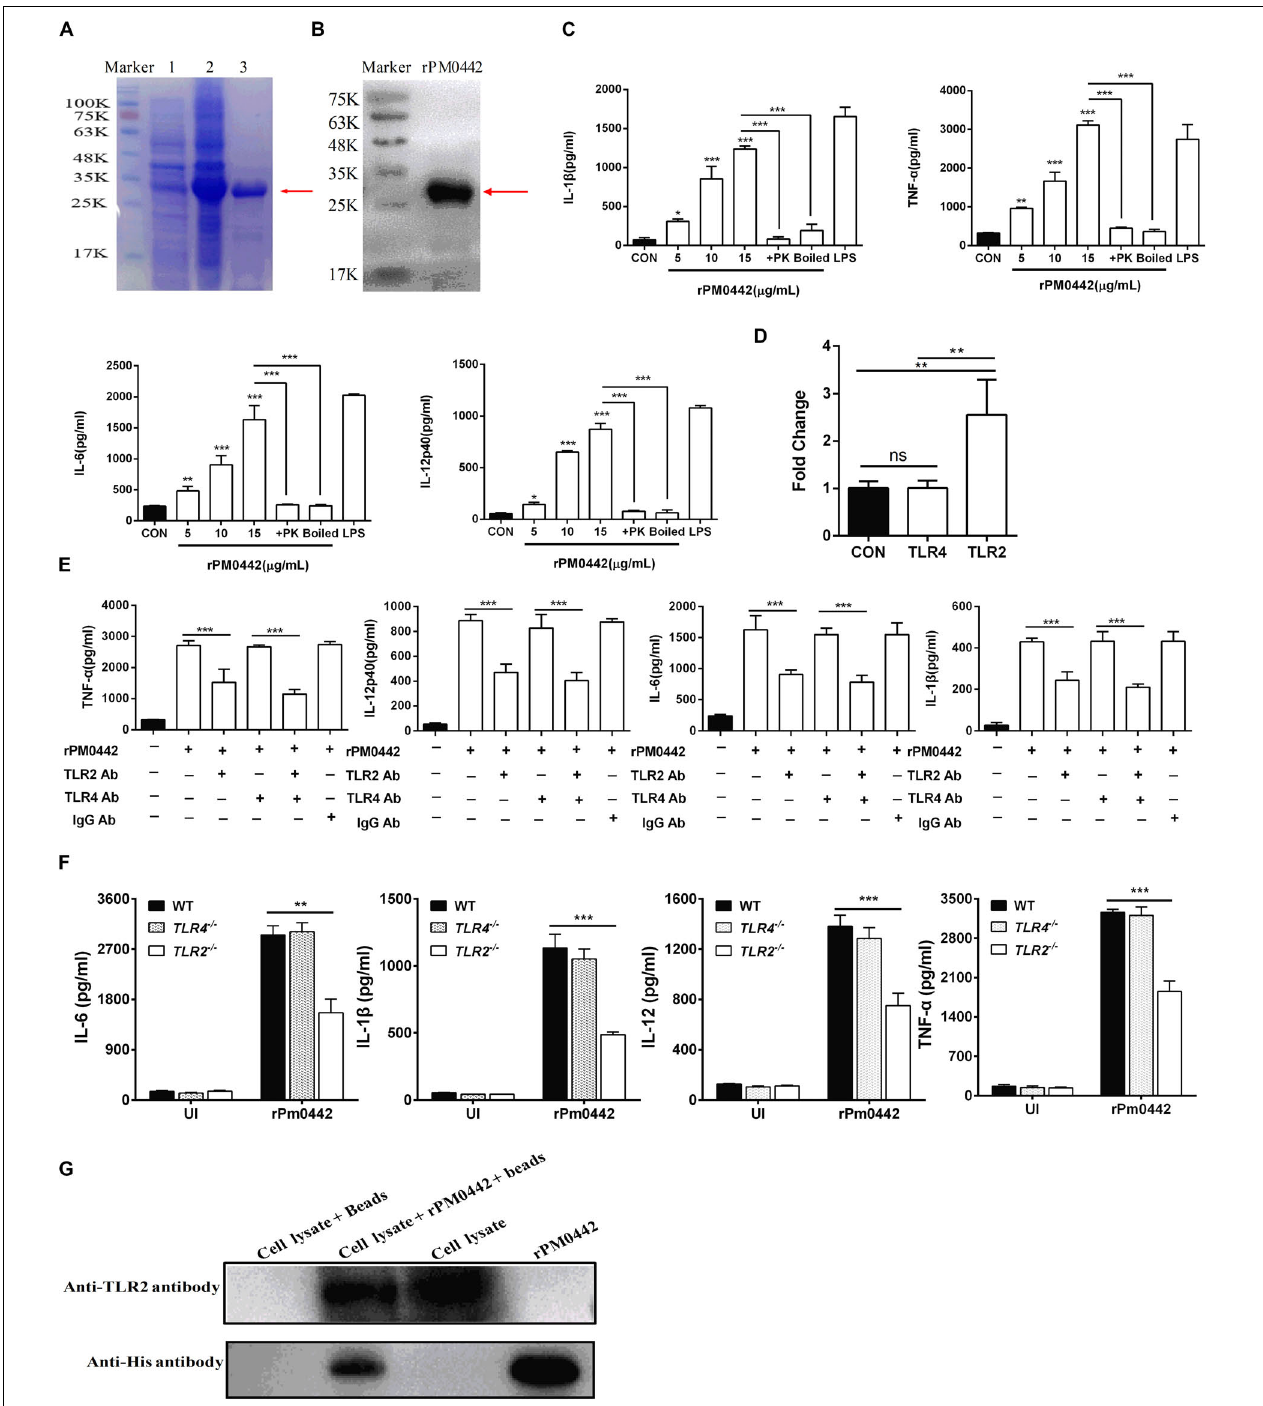
FIGURE 6 | PM0442 promotes cytokine secretion by interacting with TLR2. (A,B) SDS-PAGE (A) and western blot images (B) for expression and purification of rPM0442 protein of P. multocida . Lane 1: The untranslated protein band, Lane 2: the expression of the rPM0442 protein band induced by IPTG, 3: the protein band after purification by the HIS-Ni column. (C) rPM0442 induces secretion of IL-1 β , TNF- α , IL-6, and IL-12p40 in peritoneal macrophages. (D) TLR2 and TLR4 expression after rPM0442 protein treatment. (E) TLR2-specific antibodies reduce the production of IL-1 β , TNF- α , IL-6, and IL-12p40 in macrophage induced rPM0442 protein. (F) TLR2 - / - macrophages have reduced secretion of IL-1 β , TNF- α , IL-6, and IL-12p40 in macrophage induced rPM0442 protein. (G) Pull-down experiment to analyze the binding of rPM0442 to TLR2. Panels (A,B,G) were representative of three independent experiments. Panels (C–F) representative of three independent experiments with 8 replicates per group. Panel (C) was determined by one-way ANOVA. Panels (D–F) were analyzed with by unpaired t -test or Mann–Whitney test. The data significance was expressed as means ± SD (* P < 0.05, ** P < 0.01, *** P < 0.001).